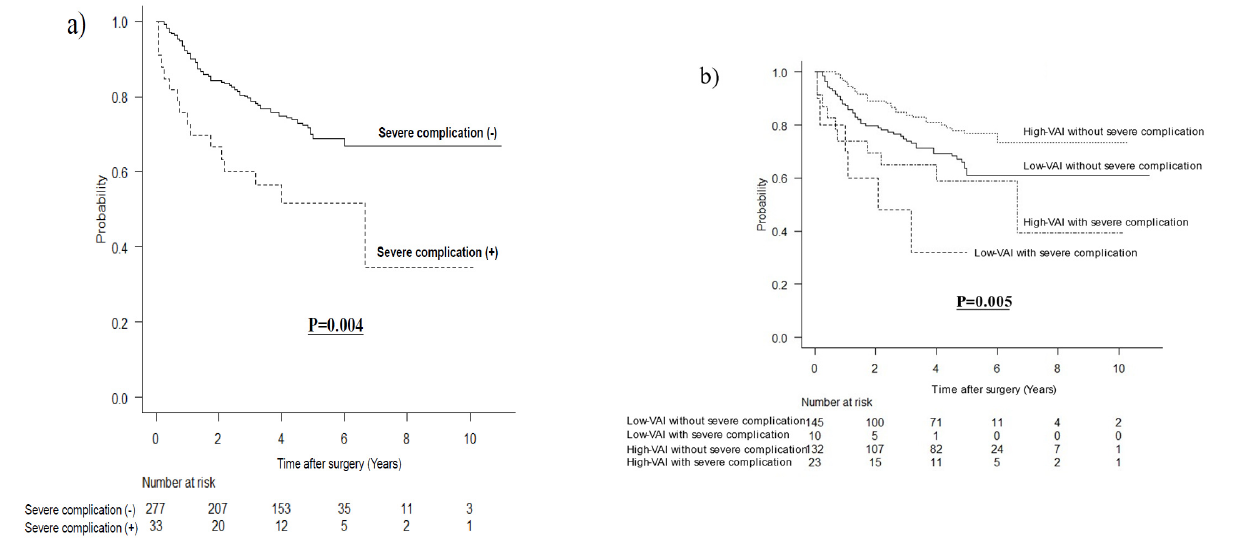
Figure 3. Kaplan-Meier survival curves for overall survival. ( a ) according to severe postoperative complications after matching; ( b ) stratified by visceral adipose tissue and severe postoperative complications after matching.